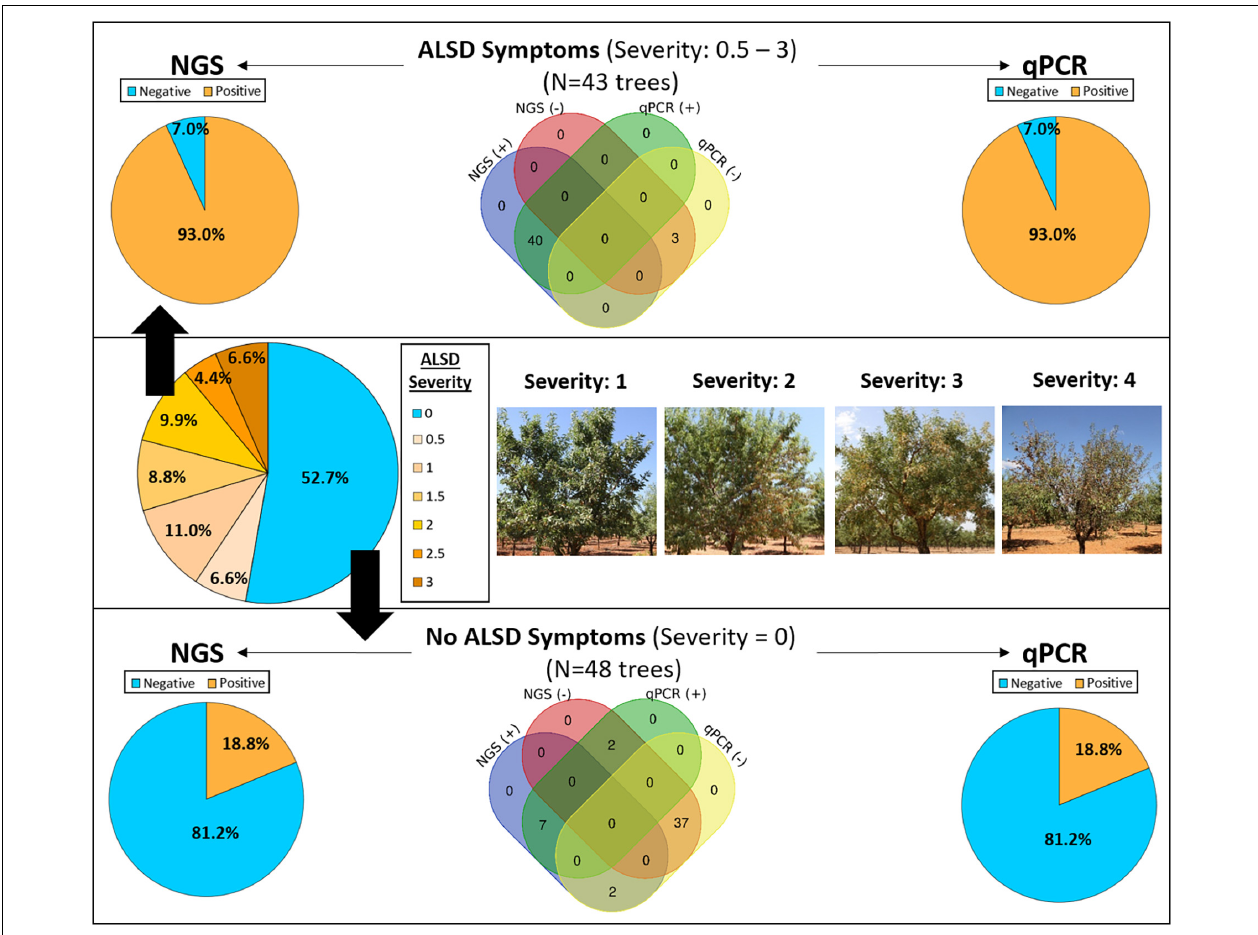
FIGURE 1 | Detection of Xylella fastidiosa by next-generation sequencing (NGS) and quantitative polymerase chain reaction (qPCR) from xylem samples obtained from asymptomatic (blue color) and almond leaf scorch disease (ALSD) symptomatic almond trees showing different ALSD severity values (from 0.5 to 3, orange color). No trees showing a disease severity of four were